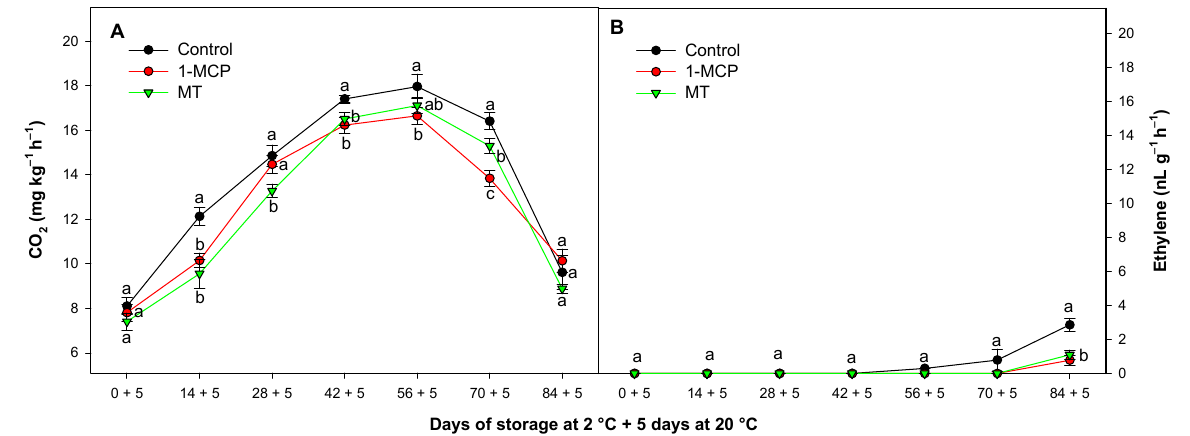
Figure 2. Evolution of respiration rate (mg CO 2 kg − 1 h − 1 ) ( A ) and ethylene production (nL g − 1 h − 1 ) ( B ) of ‘Hayward’ kiwifruit treated with distilled water (Control), 1-MCP at 0.5 µL L − 1 , or melatonin at 0.1 mM (MT) during cold storage plus 5 days at 20 °C. Data are the mean ± SE ( n = 3). Different lowercase letters show significant differences ( p < 0.05) among treatments for each sampling date.